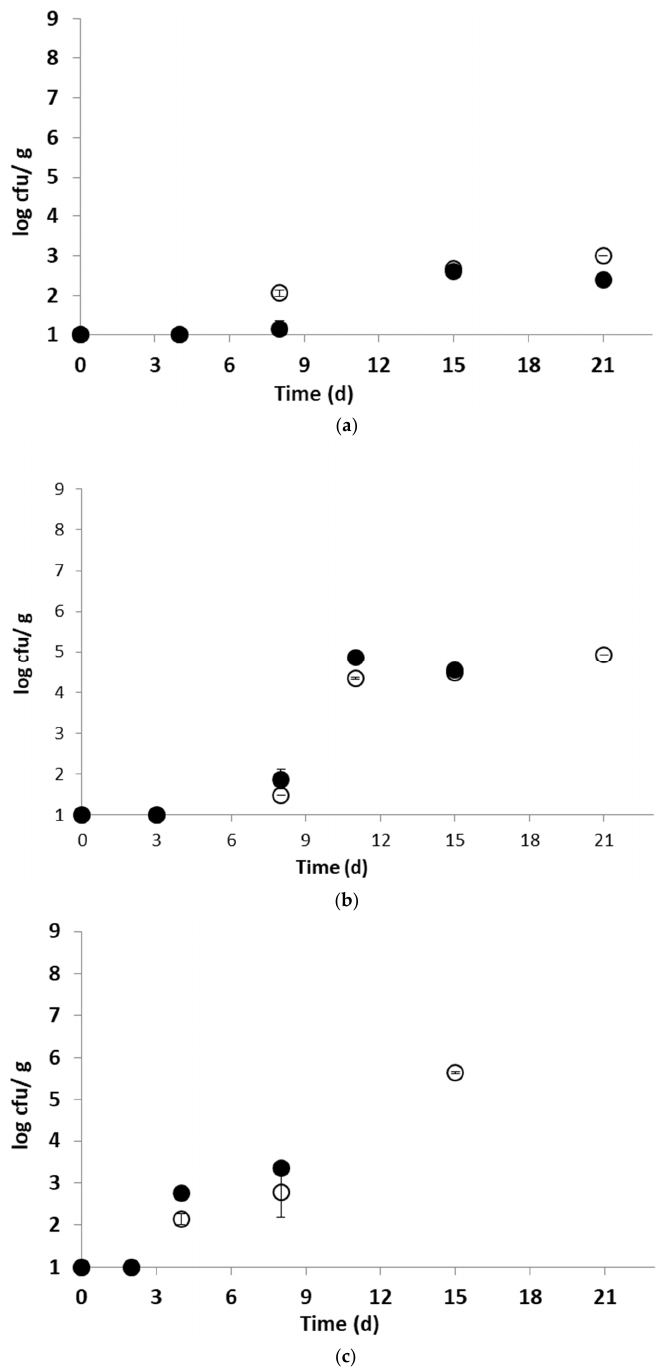
Figure 6. Lactic acid bacteria count in MAP and ACT-MAP sea bass during the isothermal storage at ( a ) 0 °C, ( b ) 5 °C, and ( c ) 10 °C ( ○ ACT-MAP, ● MAP).